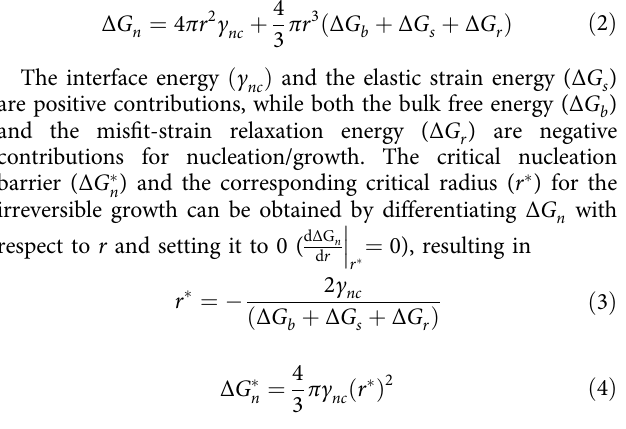
fi ed STEM 2 . Scale bar, 5 nm. f Magni